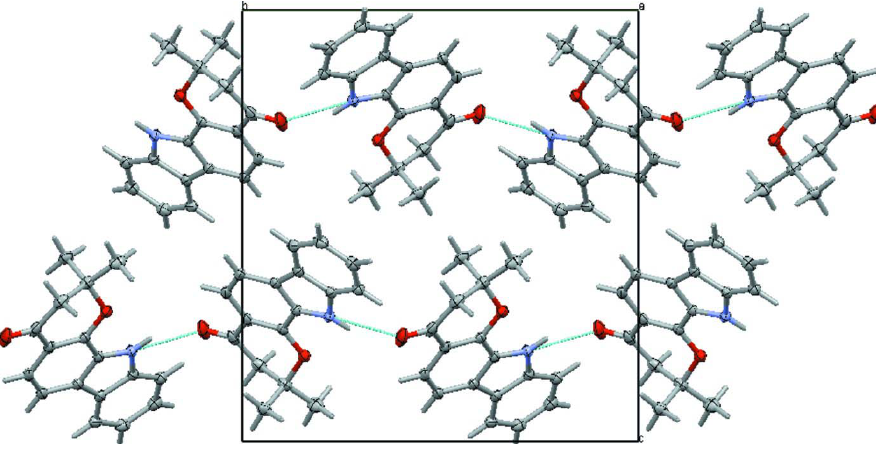
Packing view of (I) down the a axis showing chains built by the N—H···O hydrogen bonds (indicated by blue dashed